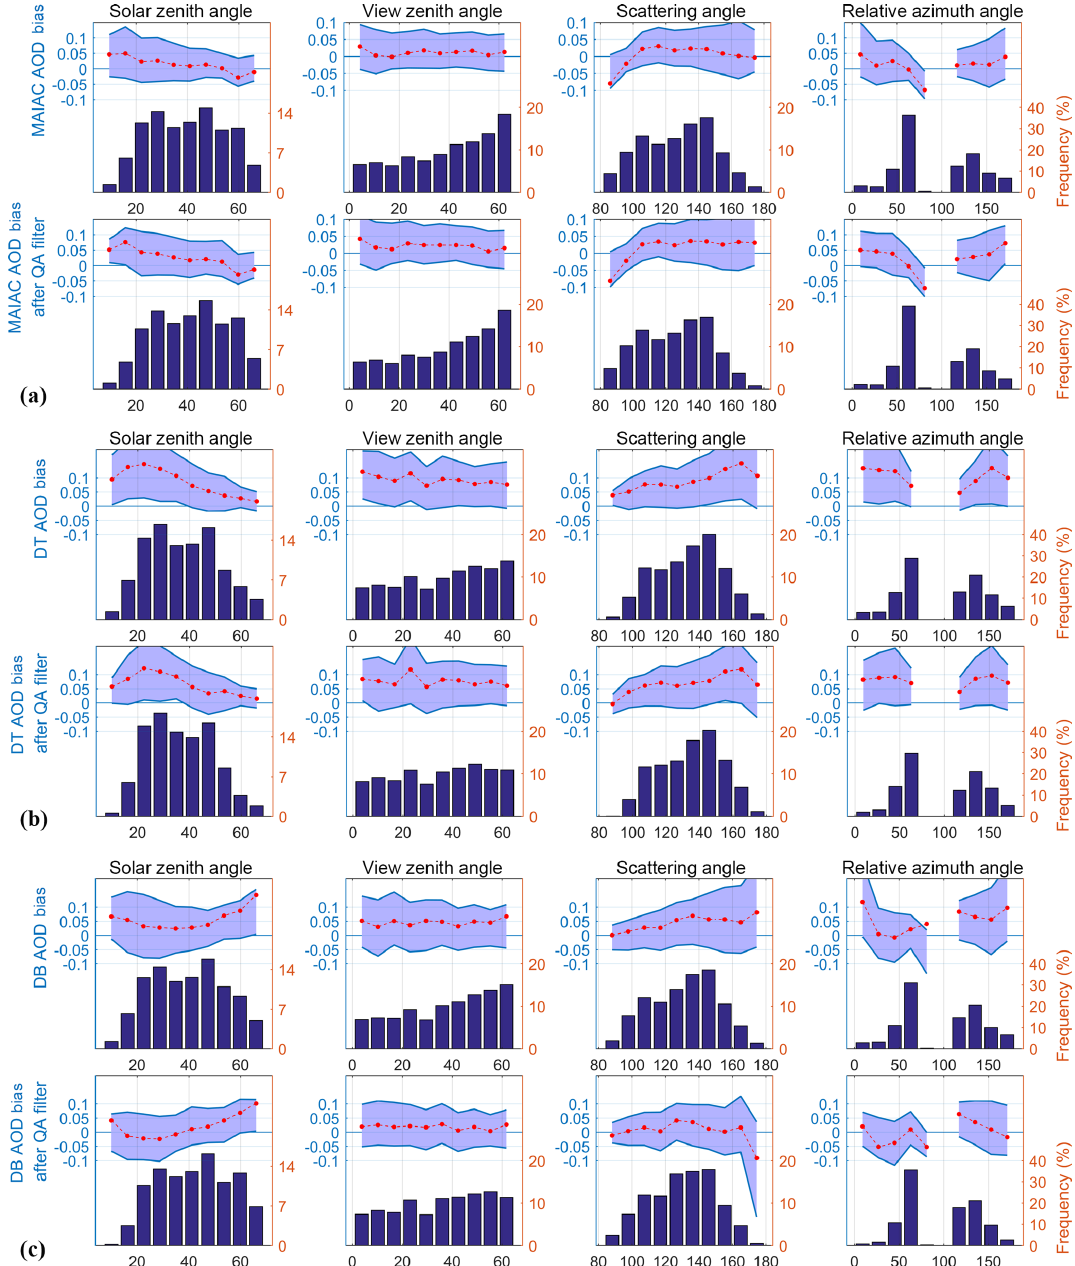
Figure 8. Dependency of the AOD bias on the solar zenith angle, view zenith angle, scattering angle, and relative azimuth angle for the (a) MAIAC product, (b) DT product, and (c) DB product before and after the QA filter. The dark blue bar is the histogram bin, red points in the shadowed area are the mean bias of the corresponding bin, and the top and bottom blue lines are the 75% and 25% percentiles of the AOD biases in the corresponding bin,